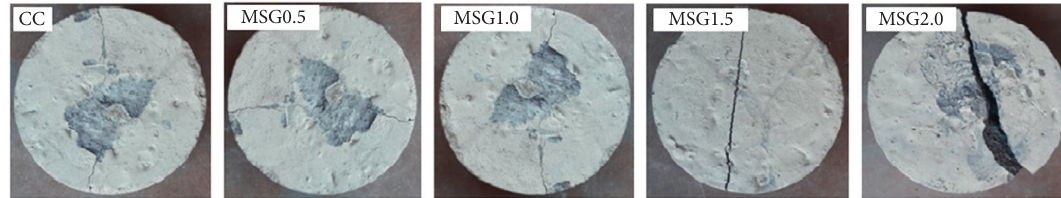
Figure 10: Specimens tested against impact force.